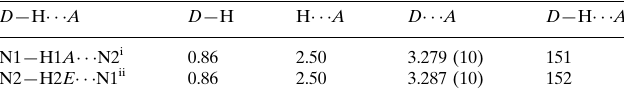
Hydrogen-bond geometry (A˚ , (cid:2)